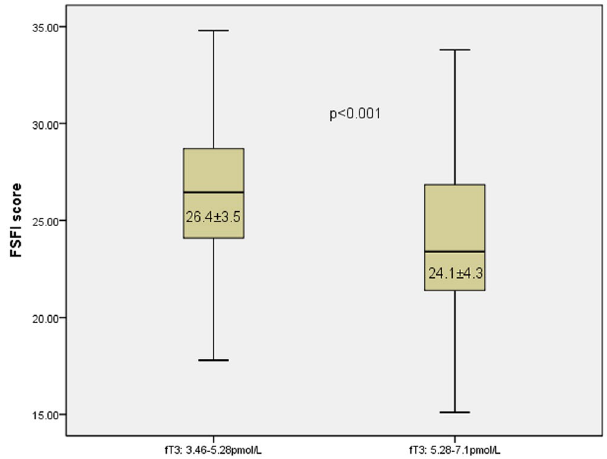
Figure 1. Participants were divided into two groups based on fT3 value (range: 3.46–7.1 pmol/L): 795 (3.46– 5.28 pmol/L) and 324 (5.28–7.1 pmol/L). The box-plot indicates that the CVFSFI score differed significantly between the two groups, P <